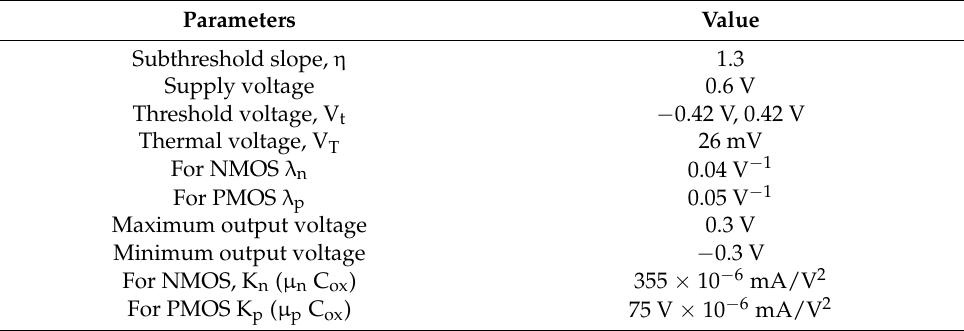
Table 2. Specifications for the circuit